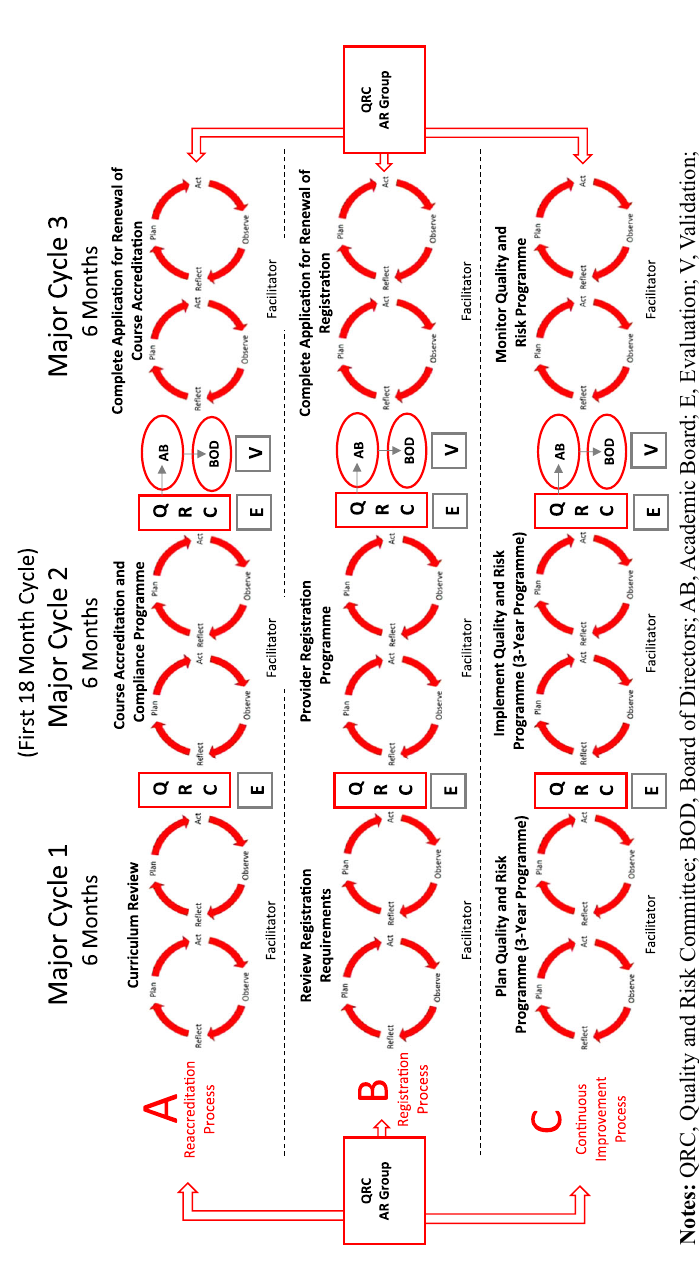
Figure A1. AIB WAL quality and risk implementation